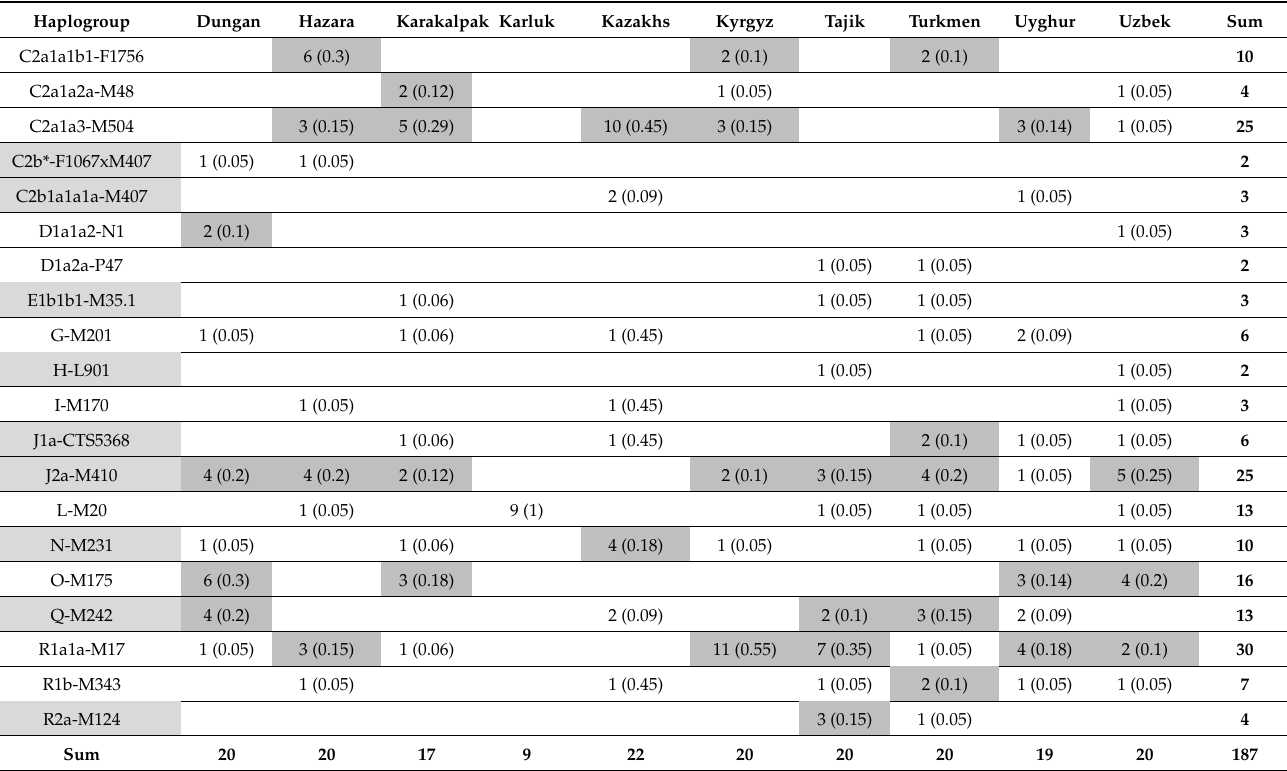
Table 1. Frequencies of Y-chromosome haplogroups in various populations. Gray shading indicates the data that had a frequency higher than